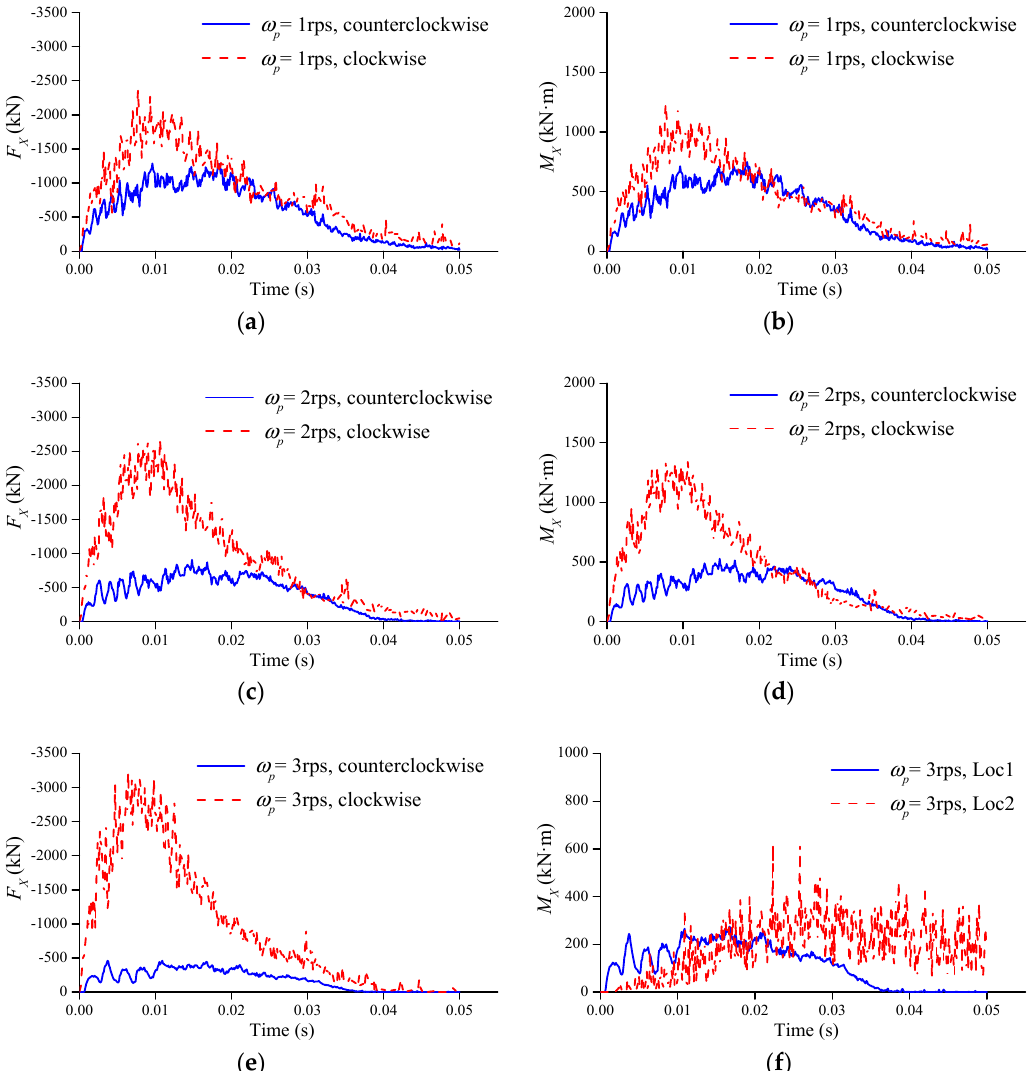
Figure 20. Time series of ice load Fx and Mx based on simulations with di ff erent rotation directions. ( a ) The Fx with 1 rps. ( b ) The Mx with ( c ) The Fx with 2 rps. ( d ) The Mx with 2 rps ( e ) The Fx with 3 rps. ( f ) The Mx with 3